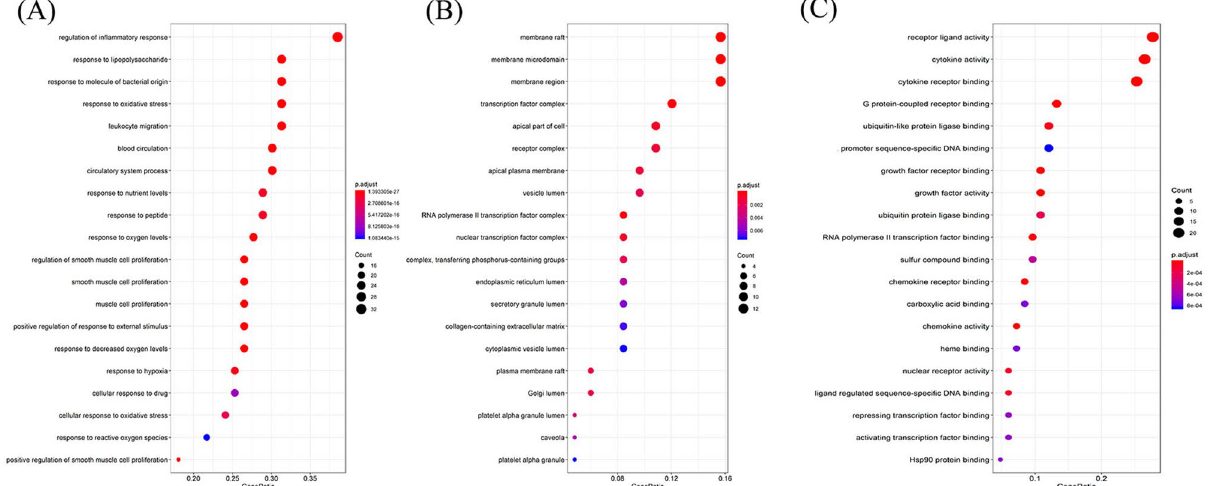
Figure 4. GO enrichment analysis of the putative targets. ( A ) The top 20 significant enriched terms in biological process (BP); ( B ) The top 20 significant enriched terms in cellular component (CC); ( C ) The top 20 significant enriched terms in molecular function